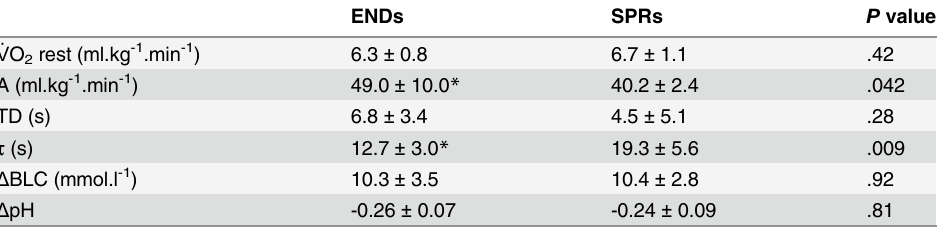
A, TD and τ are the amplitude, time delay and time constant estimated from V ̇ O2 kinetics. Δ BLC and Δ pH is the difference between pre test and peak exercise values of blood lactate concentration and pH, respectively. * Signi fi cant difference between groups ( p <